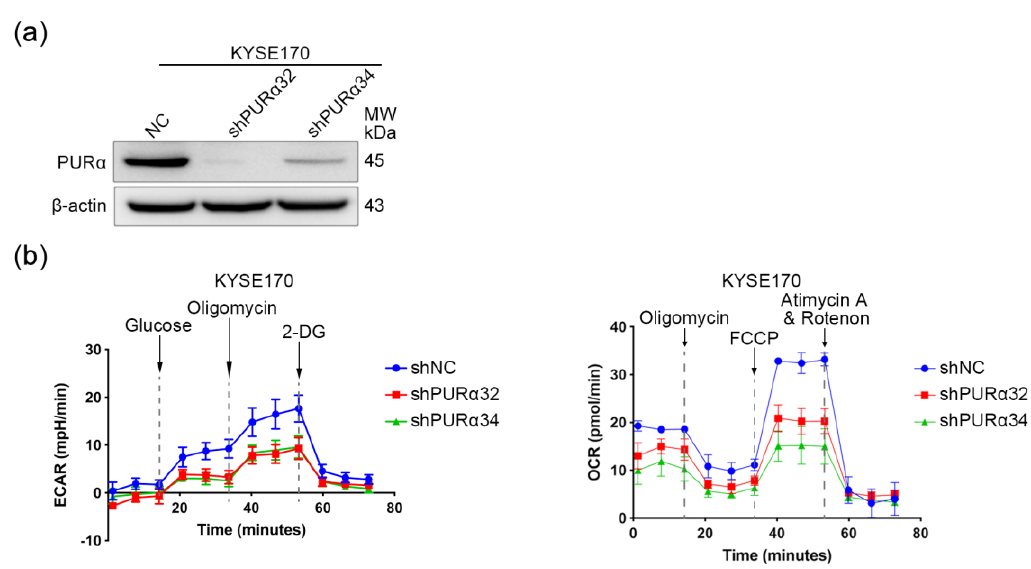
Figure 10. PUR α promotes mitochondrial respiration and glycolysis in ESCC cells. ( a ) The protein levels of PUR α in KYSE170-shNC / shPUR α 32 / 34 cells were assessed by Western blotting. ( b ) Oxygen consumption rate (OCR) and extracellular acidification rate (ECAR) detection in KYSE170-shNC / shPUR α 32 / 34 cells.